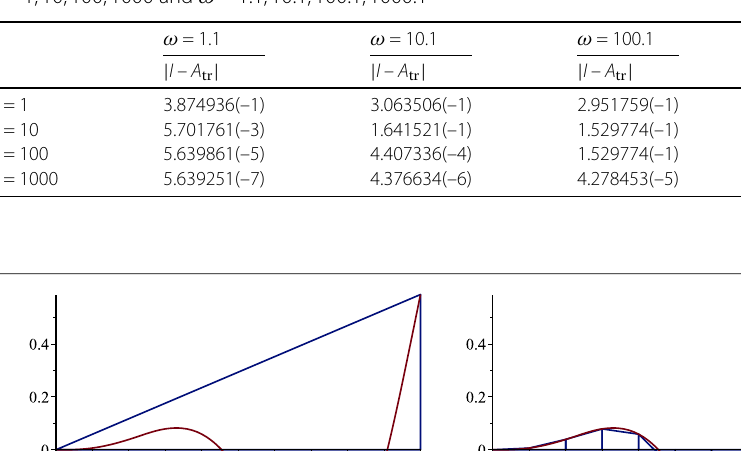
Table 1 The absolute values of the error (53) of the composite trapezoidal rule for N = 1,10,100,1000 and ω = 1.1,10.1,100.1,1000.1